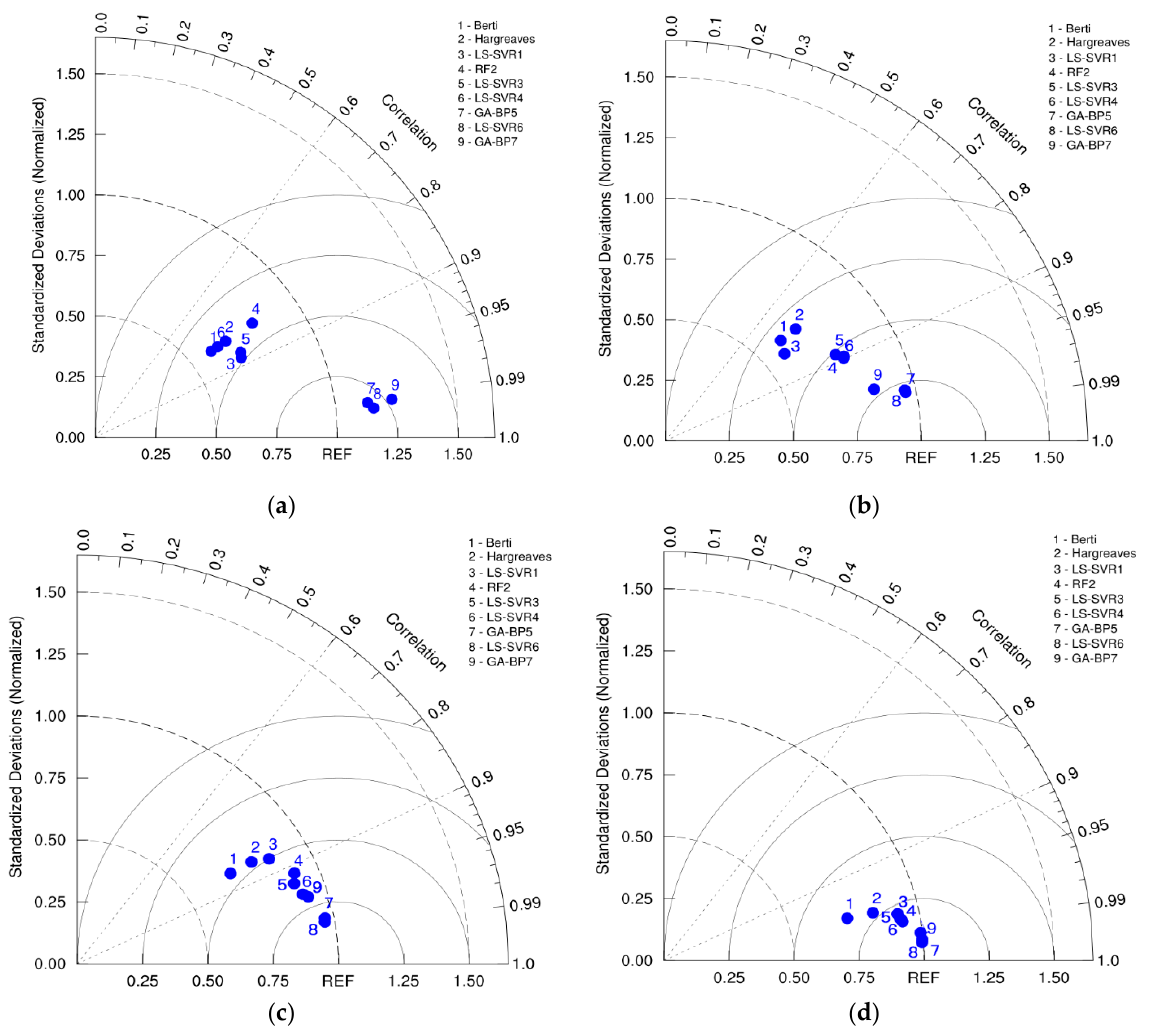
Figure 7. Evaluation of Taylor diagram for reference evapotranspiration model in different time scales; 7 days ( a ), May 2019 ( b ), quarter 2015 ( c ), 2016 ( d ).